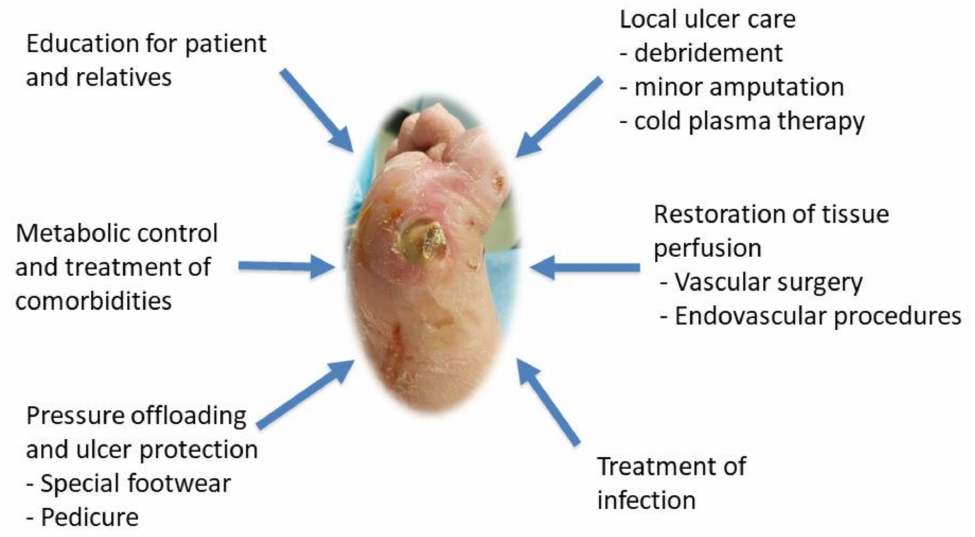
Figure 1. Conventional DFU